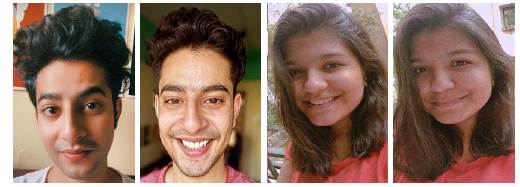
Figure 4. Examples from collected FERET